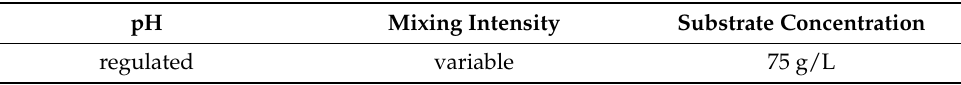
Table 4. Indication of parameters in S/N group, “the larger, the better”, under which the concentration of γ -decalactone in biotransformation medium at 45 h of Y. lipolytica batch can reach the highest values. pH Mixing Intensity Substrate Concentration regulated variable 75 g/L To verify the accuracy of the indicated parameters, a fifth biotransformation reaction